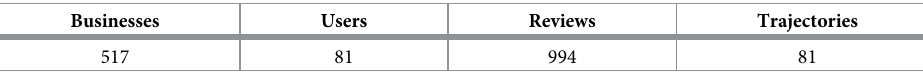
Table 3. The statistic for Las Vegas in Combination